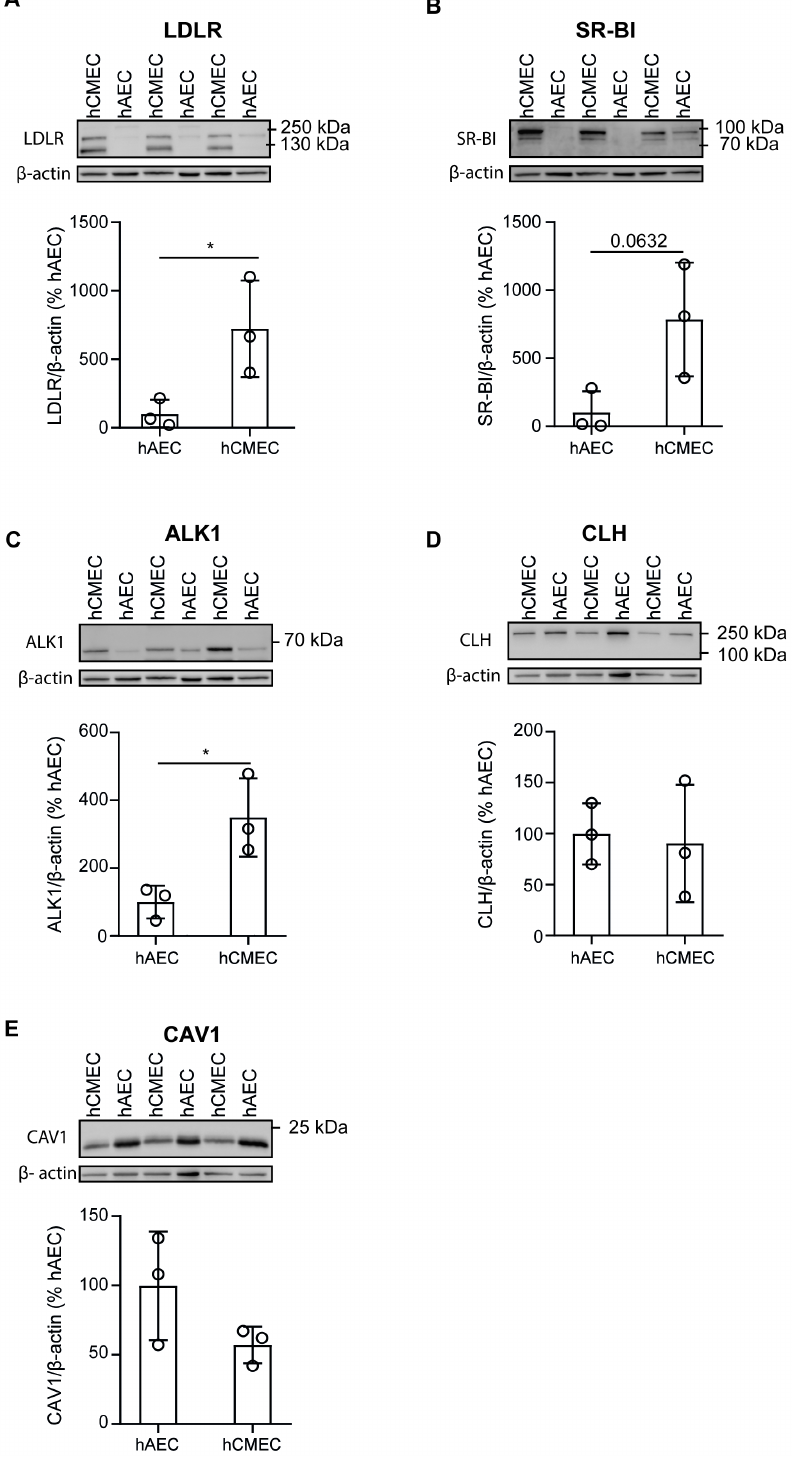
Figure 2. Brain and aortic endothelial cells express low-density lipoprotein receptor (LDLR), scav- enger receptor (SR-BI), activin-like kinase (ALK1), clathrin heavy chain (CLH), and caveolin 1 (CAV1). hAEC (from three independent individuals) and hCMEC/D3 (from three successive passages) were grown until confluence before being lysed in RIPA buffer. Equal amounts of proteins (15–25 µ g) were separated by SDS-PAGE. LDLR ( A ), SR-BI ( B ), ALK1 ( C ), CLH ( D ), and CAV1 ( E ) protein levels were measured by Western blotting and normalized to β -actin. Quantifications of band densitometry